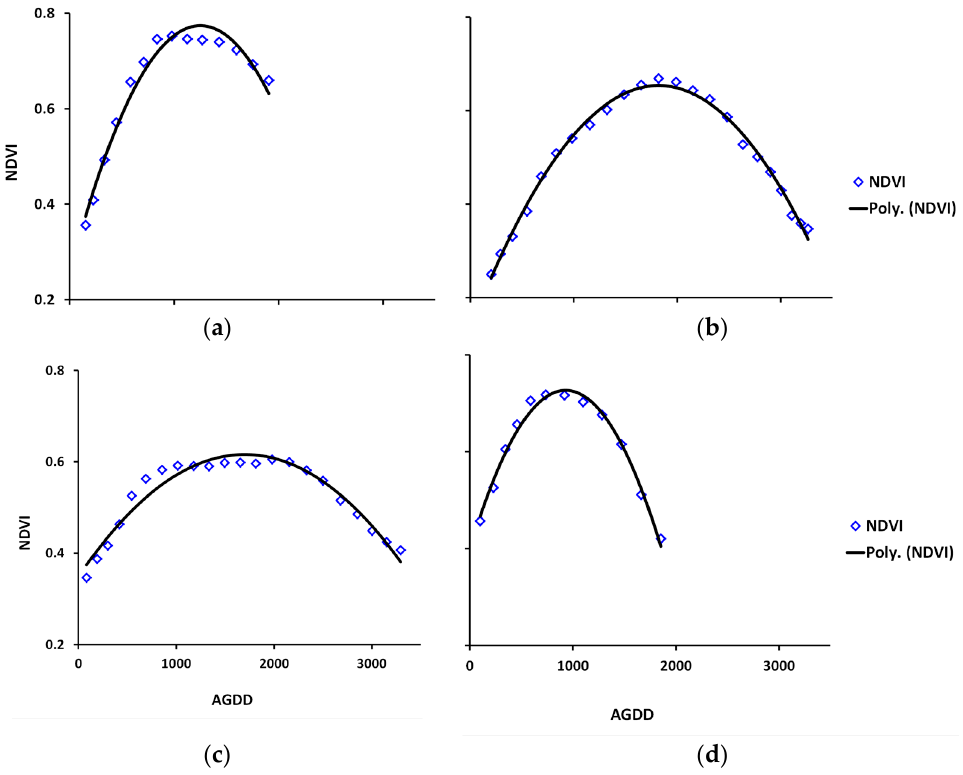
Figure 6. Average NDVI (2003–2010) as a function of AGDD for cropland sites that encompass the whole latitudinal range: ( a ) 48, RU; ( b ) 28, KZ; ( c ) 11, UA; and ( d ) 1, RU. Coefficients of determination (R 2 ) for these sites ranged from 0.88 to 0.97.